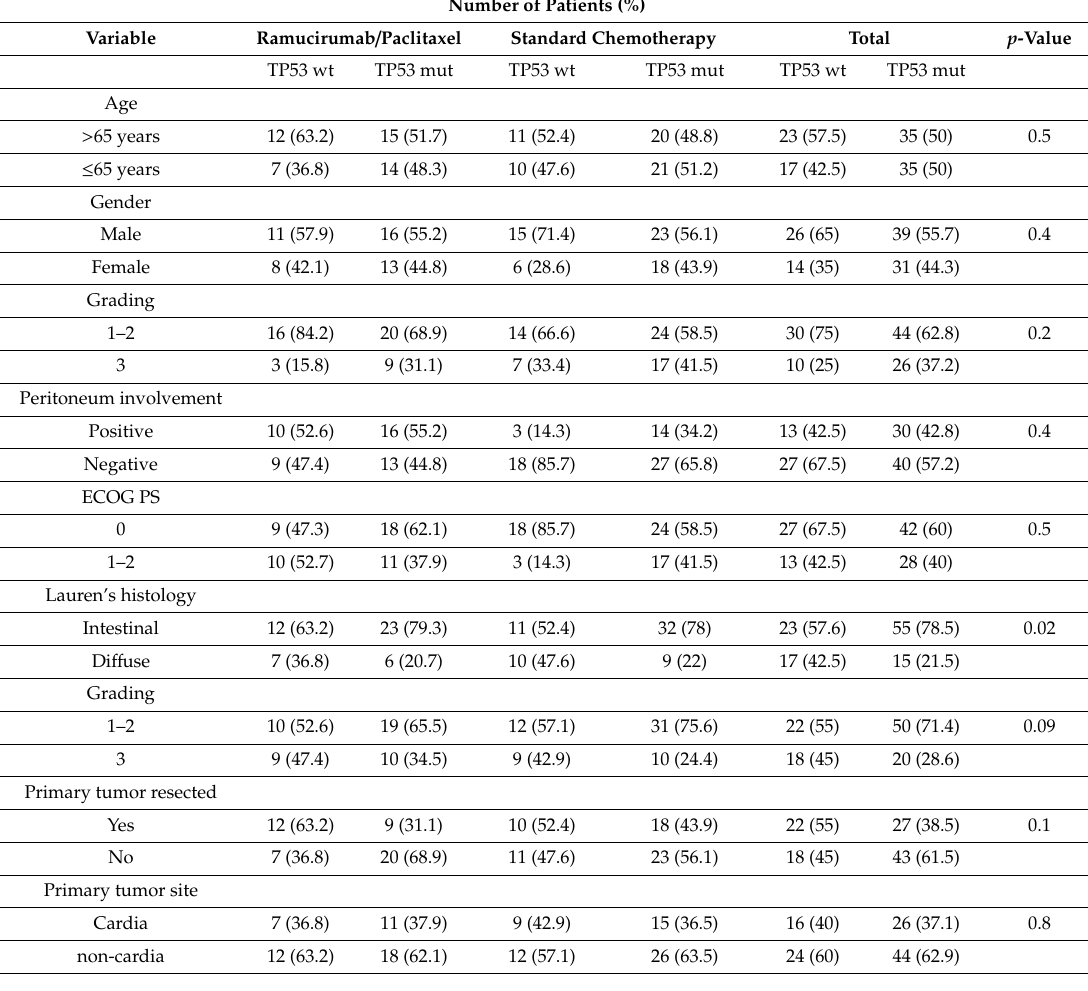
Table 2. Characteristics and distribution of the 110 patients according to treatments and TP53